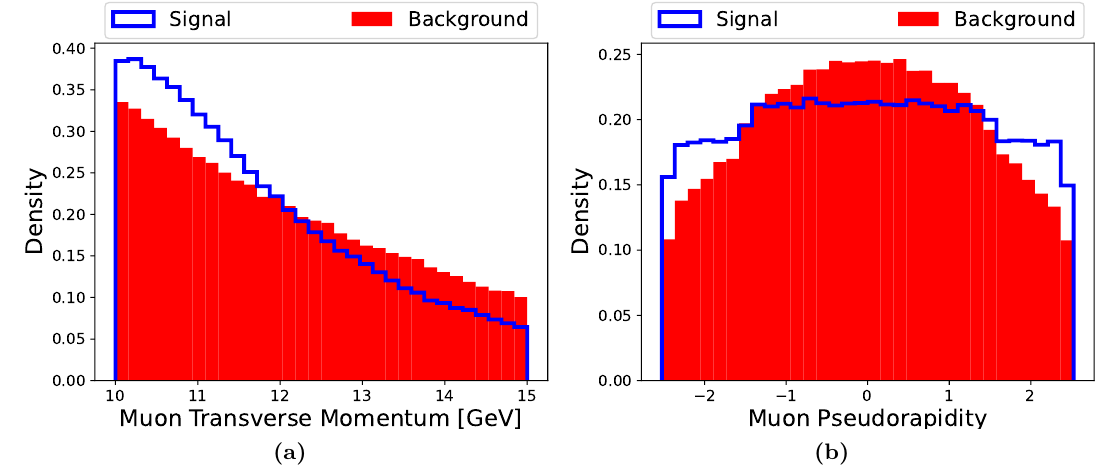
Figure 1. Distributions of muon transverse momentum (top) and pseudorapidity (bottom) for signal and background samples. Afterwards, the distributions are weighted to make both samples uniform.